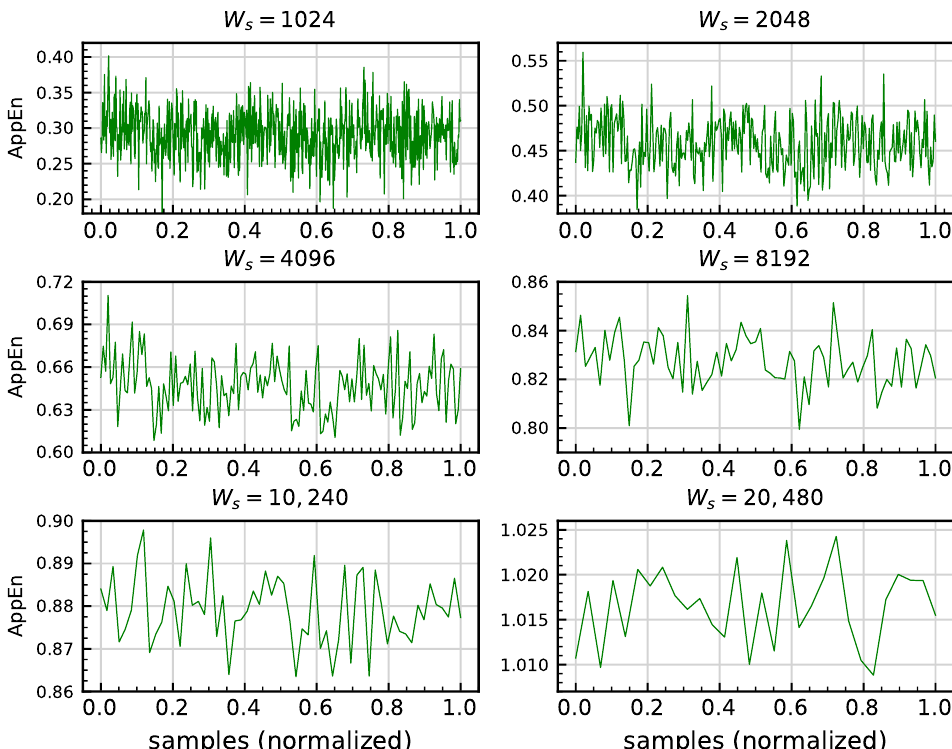
Figure 8. Approximate entropy (AppEn) calculation for bearing signal corresponding to healthy scenario HS with m = 5, r = 0.2 × σ , and varying W s